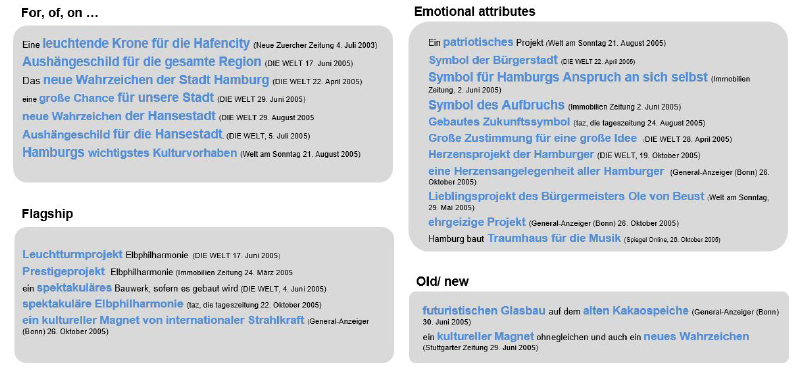
Qualifiers of the Elbphilharmonie in articles during the inception